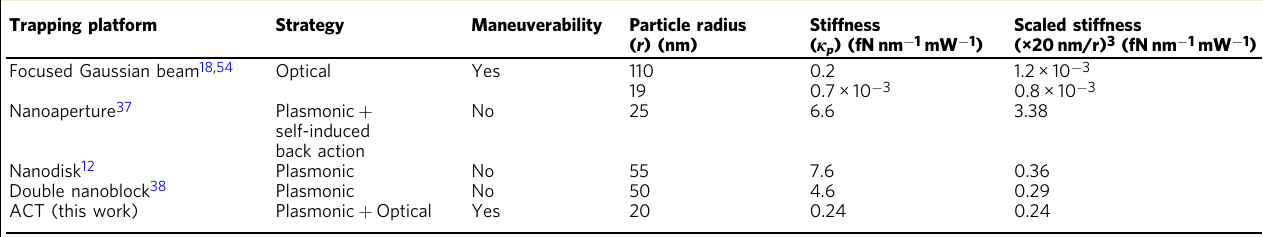
Table 1 Comparison of trap stiffness for different optical traps scaled for a 40 nm PS sphere Trapping